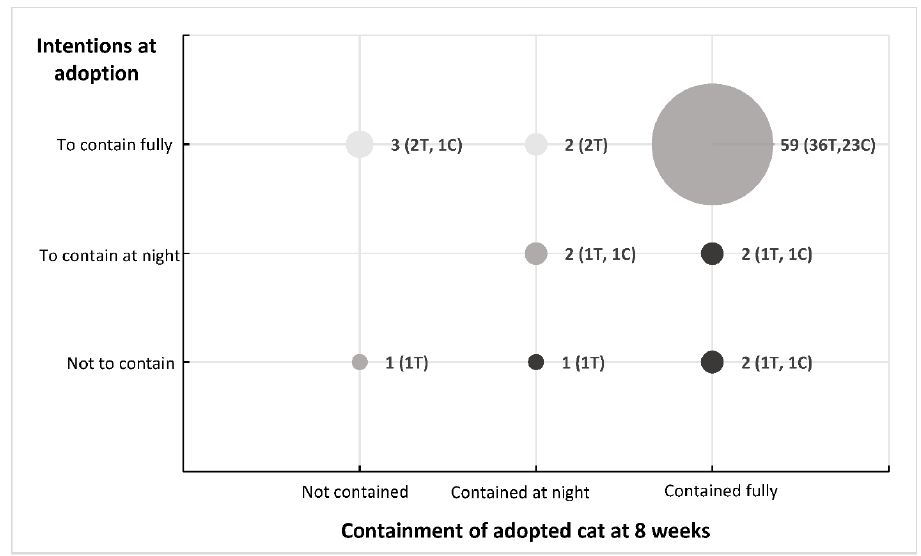
Figure 1. Summary of the containment intentions of the 72 participants at the time of adoption (vertical axis), and their containment behaviour after 8 weeks (horizontal axis). Size of dots represent number of participants. The lighter dots represent participants who did not follow through on their intentions, the darker dots represent those participants who surpassed their initial intentions. T = treatment, C = control.